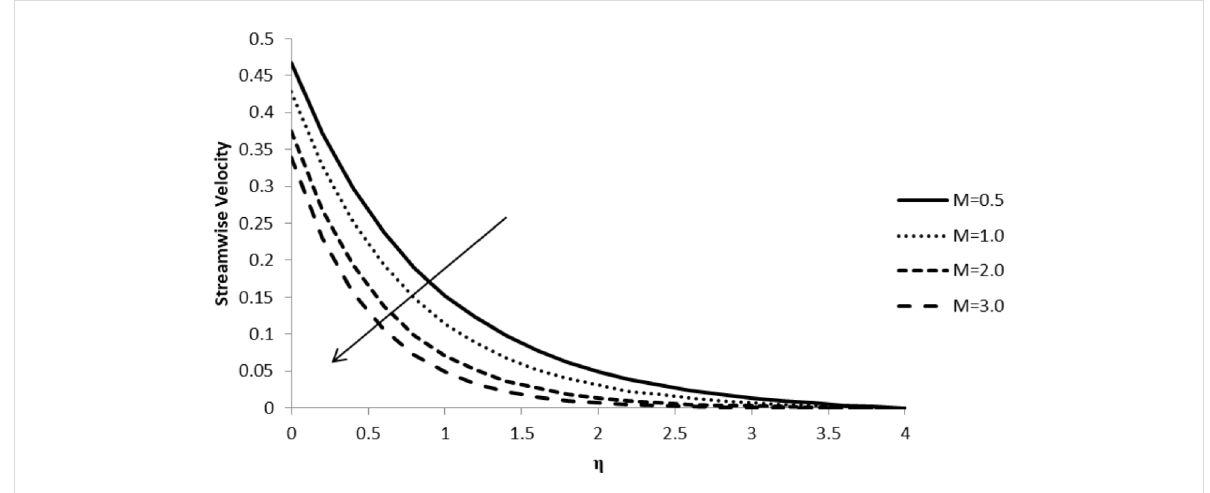
Figure 12: Influence of the magnetic parameter M on the streamwise velocity component f ´( η ) when n = 2.0, Pr = 2.0, Nb = Nt = 0.5, Q = 0.0, Le = 5.0, ξ = 1.0, and F w = 0.2.